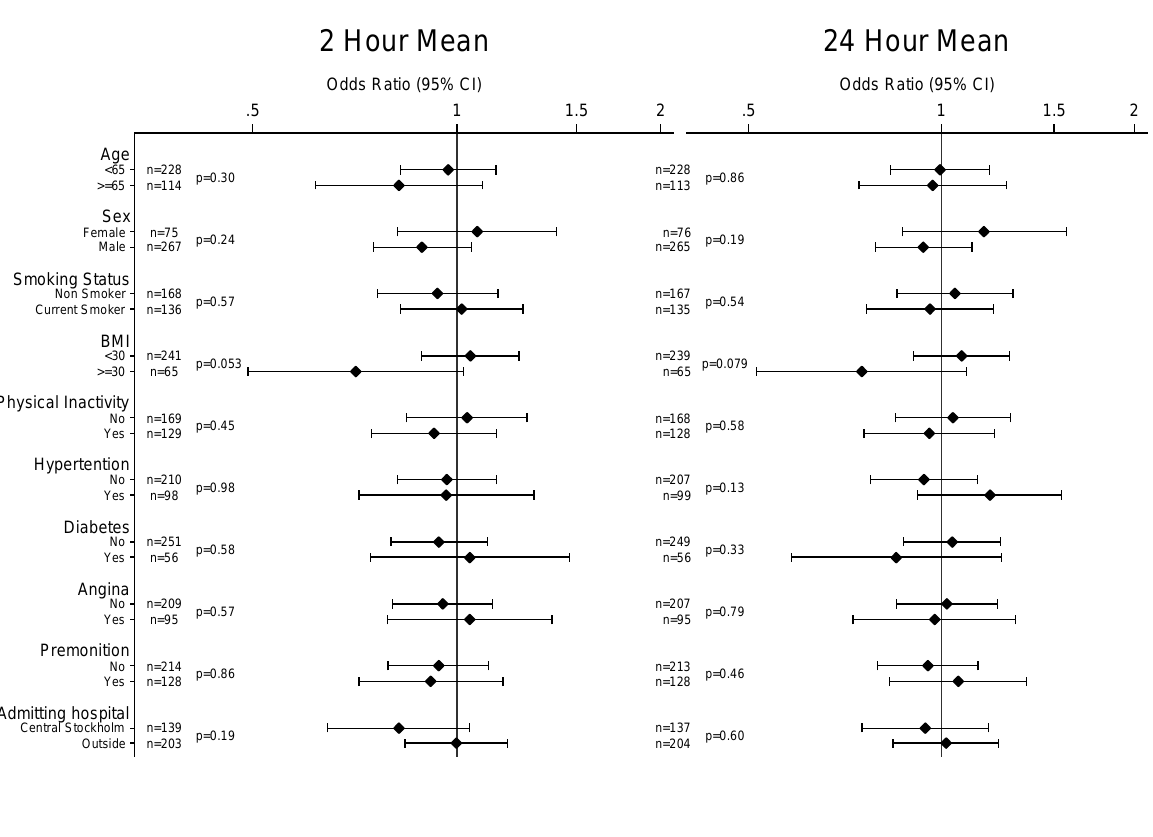
Figure 1. Odds ratios of myocardial infarction for an interquartile range increase in 2 h and 24 h moving averages of PM in different subgroups (P-values for interaction). Number of 10 observations for each subgroup with complete data on analyzed covariate and air pollution indicated by